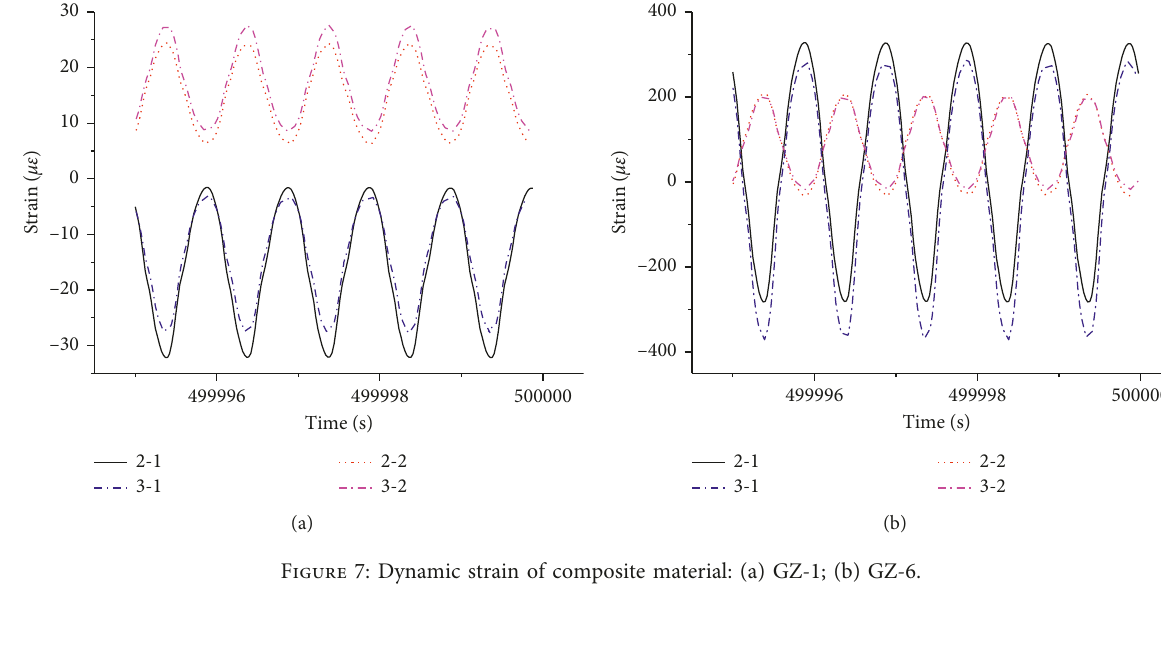
Figure 7: Dynamic strain of composite material: (a) GZ-1; (b) GZ-6.